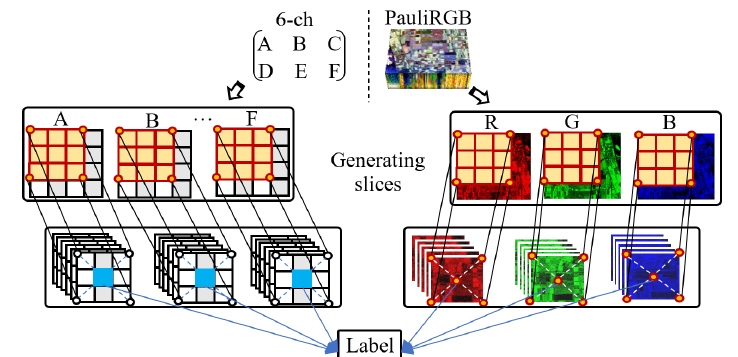
Figure 3. The generation of the fixed-size slices based on the center